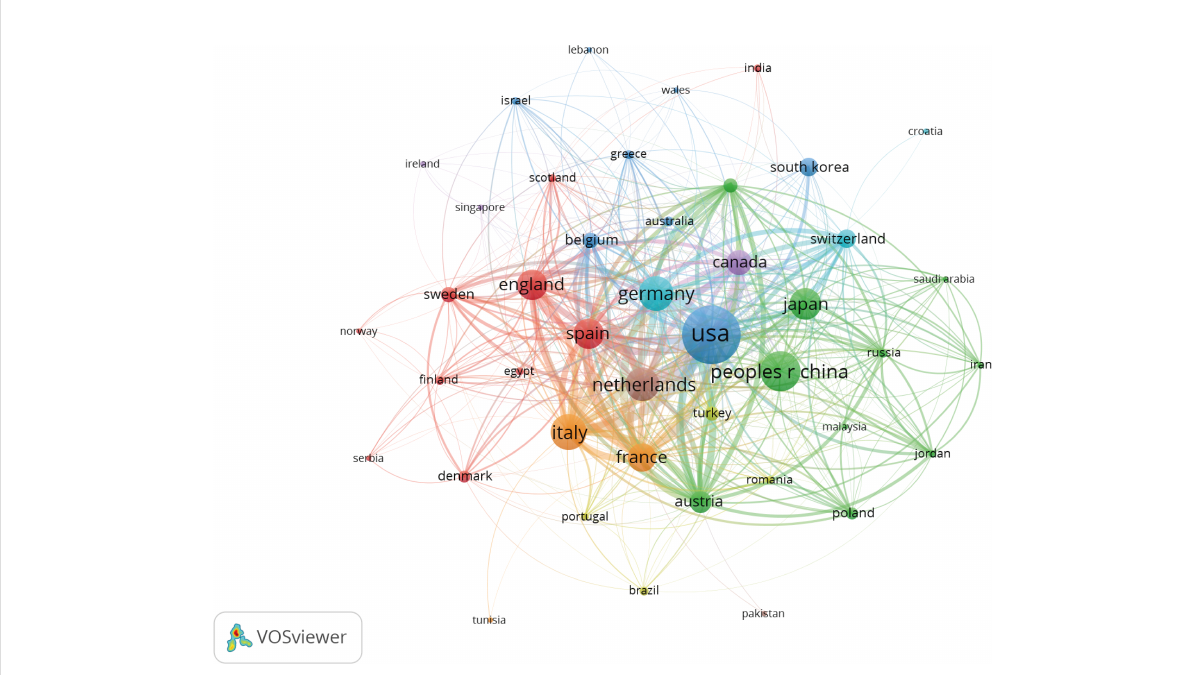
FIGURE 4 Co-occurrence map of Countries/Regions. The size of the nodes represents the number of articles; the thickness of the curve represents the strength of the collaboration; the colors represent different collaboration